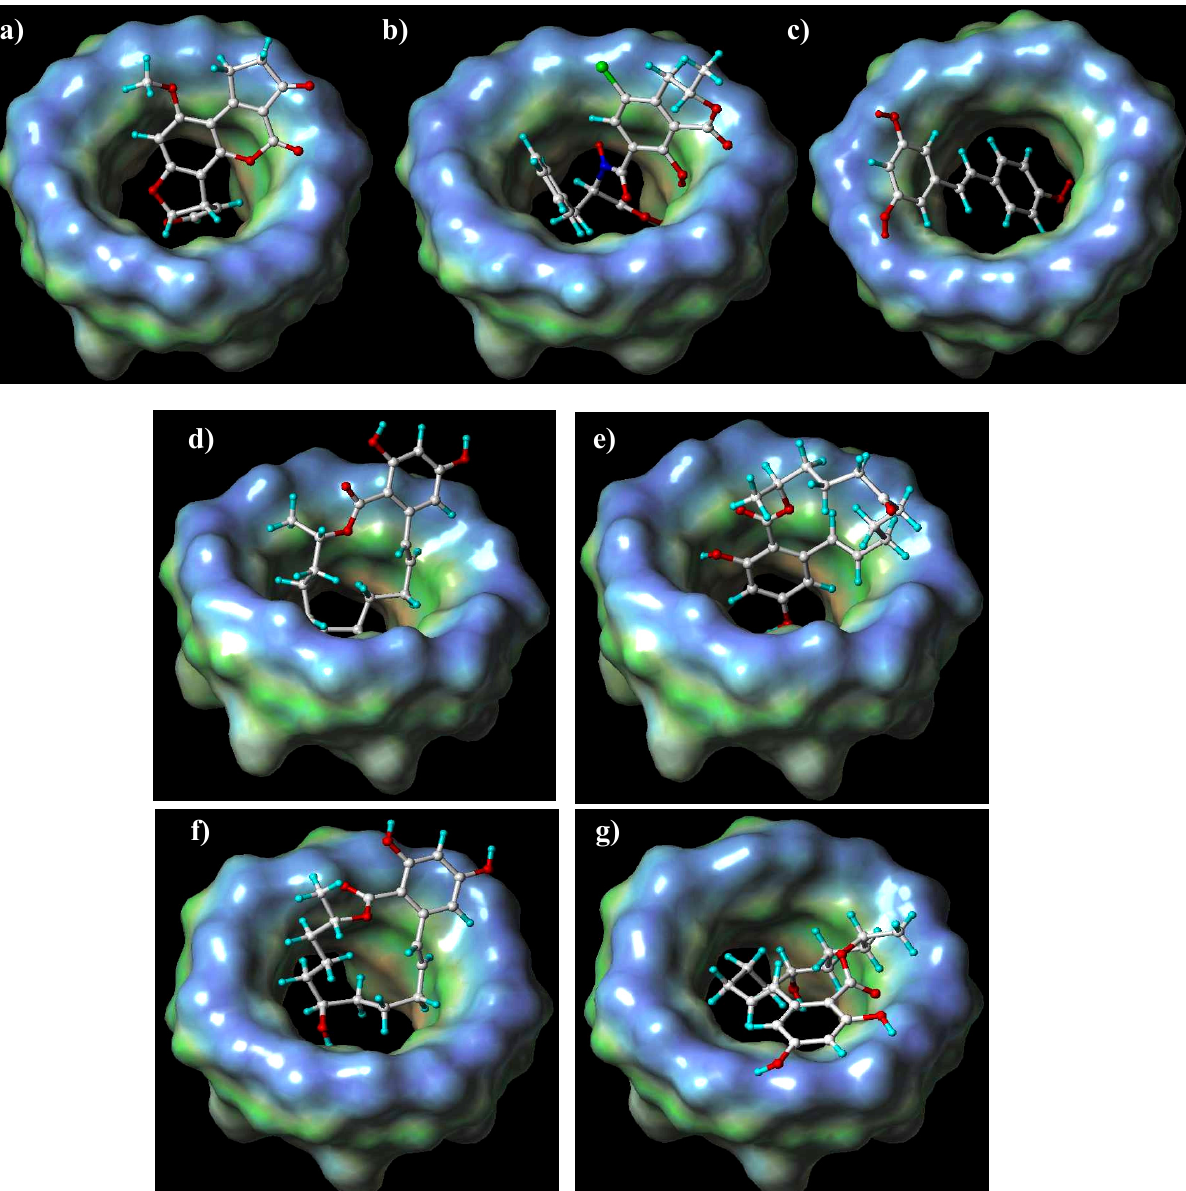
Figure 4. Docking results for a): AF1 and β -CD; b): OTA and β -CD; c): RES and β